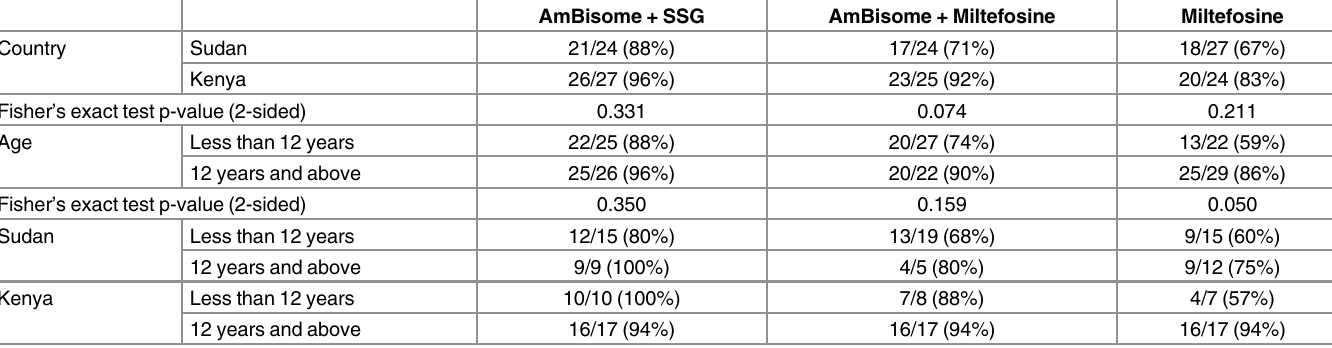
Table 6. Stratified D210 efficacy.